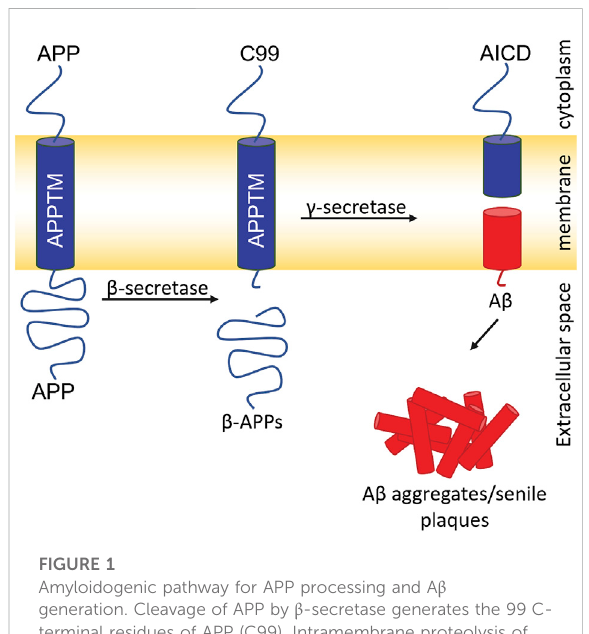
FIGURE 1 Amyloidogenic pathway for APP processing and A β generation. Cleavage of APP by β -secretase generates the 99 C- terminal residues of APP (C99). Intramembrane proteolysis of C99 by GS generates A β 40/42. A β aggregates generating senile plaques a major pathogenic hallmark of AD.